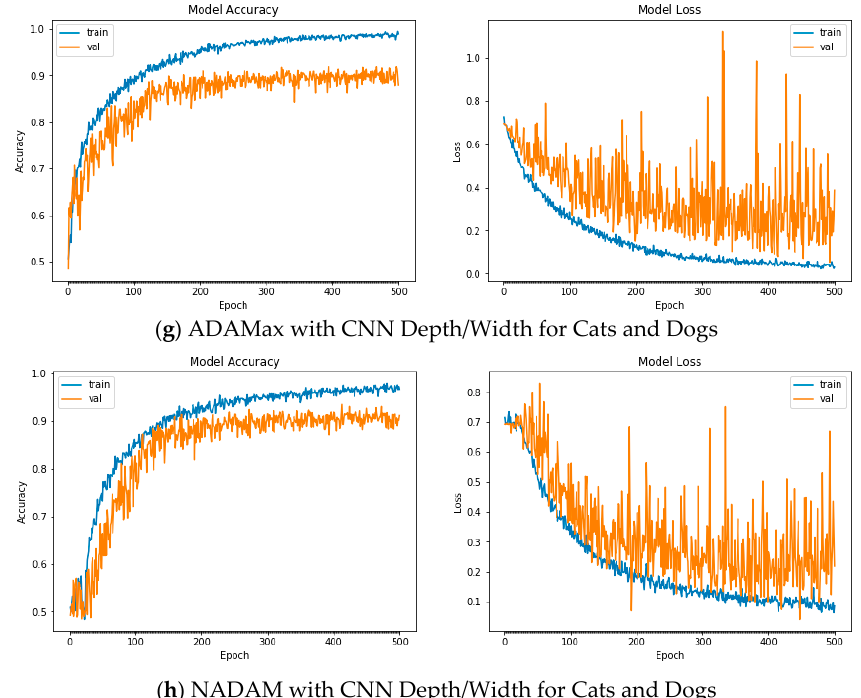
Figure A7. Plots of Train and Validation Test accuracies and losses of the CNN model with varying depth/width for Cats and Dogs: ( a ) Vanilla SGD; ( b ) SGD momentum; ( c ) SGD Nesterov momentum; ( d ) ADAGrad; ( e ) RSMProp; ( f ) ADADelta; ( g ) ADAMax; ( h ) NADAM.